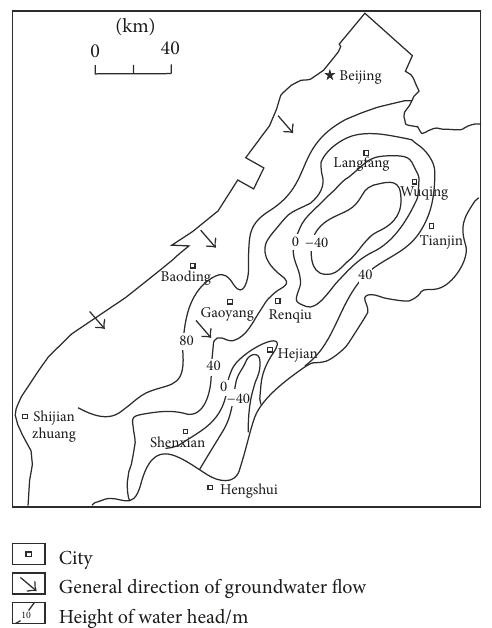
Figure 4: The water head of formation water in buried hill, Jizhong